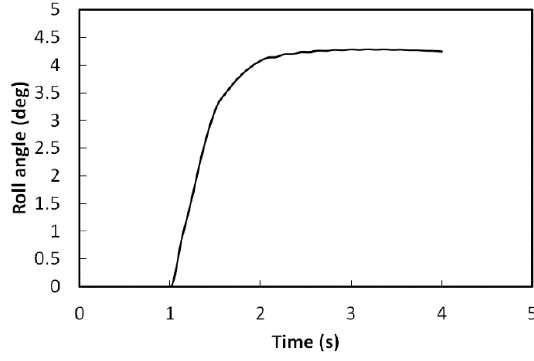
Figure 19. The roll angle with middle level